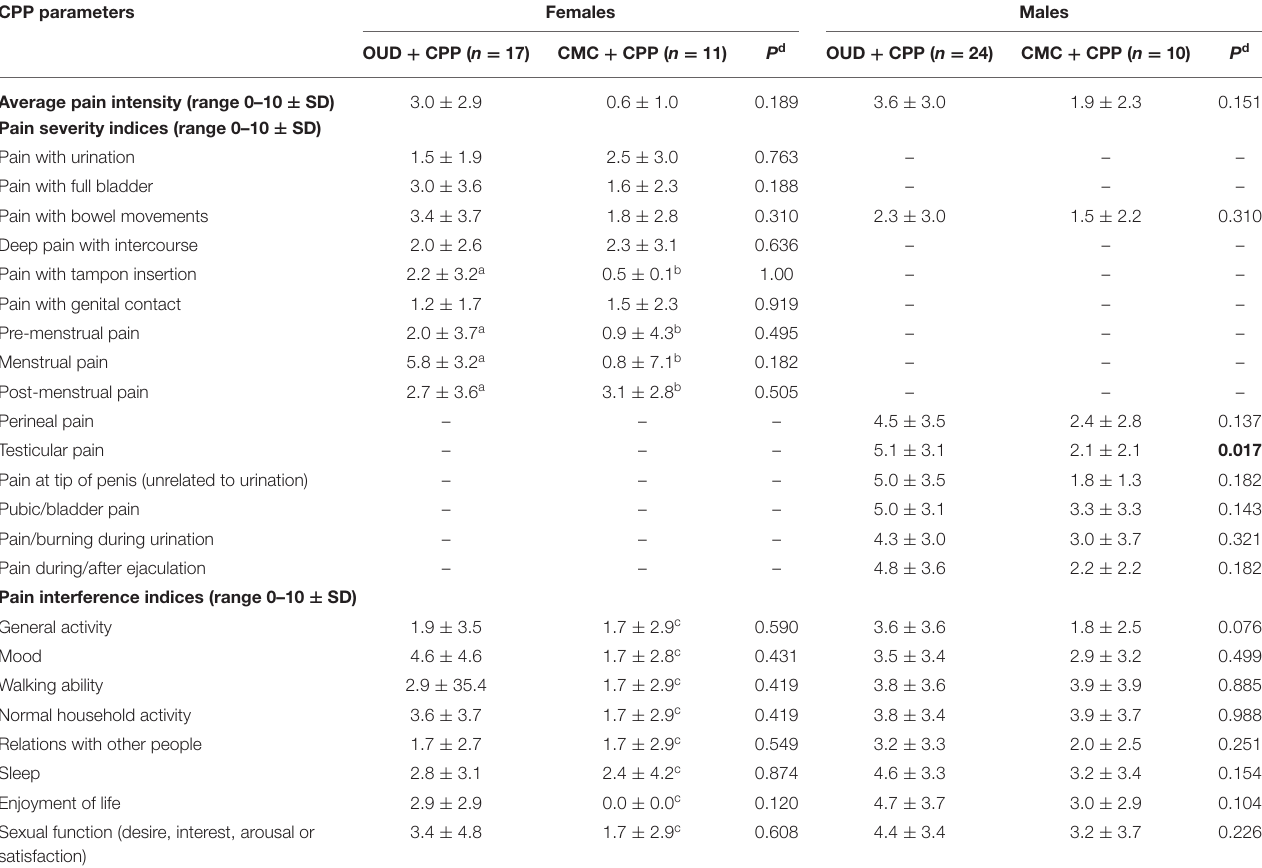
TABLE 2 | Pain parameters, severity indices, and interference indices among participants with CPP. CPP parameters